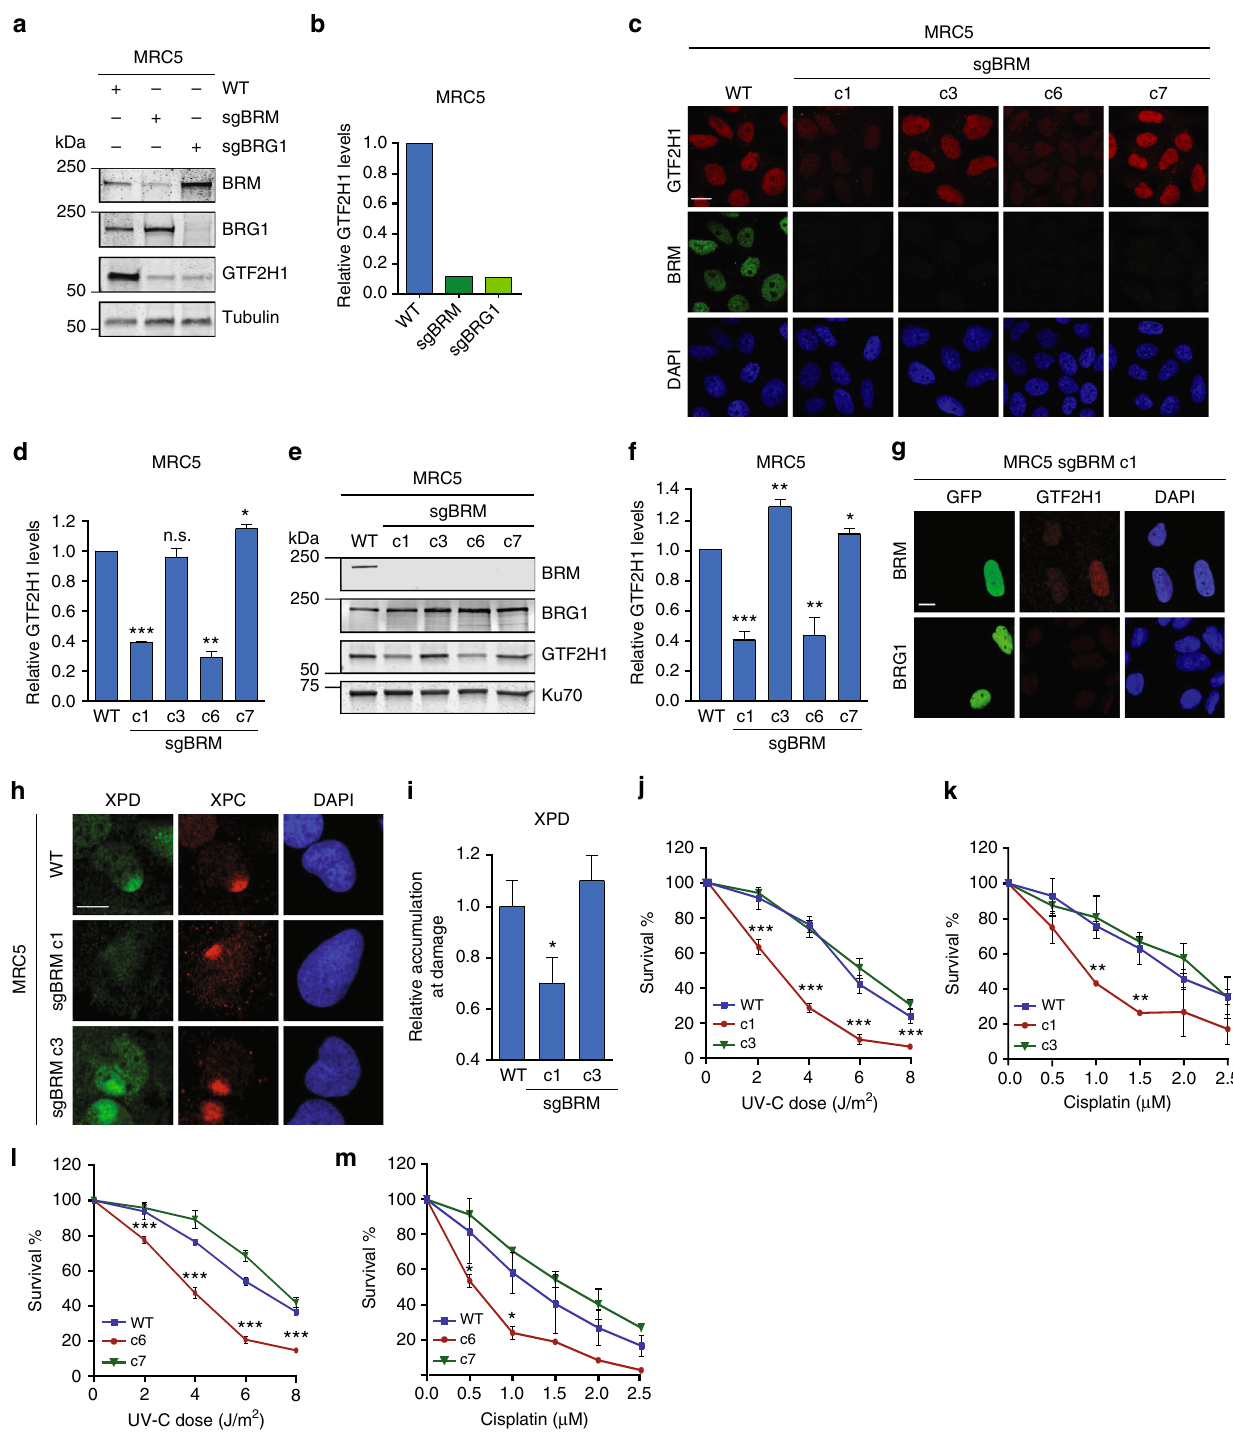
proposed, in facilitating XPG and PCNA — but not DDB2 and XPC — recruitment to sites of damaged DNA 24 . Our data, indeed, shows that both BRG1 and BRM are essential for ef fi cient recruitment of late NER factors (TFIIH and downstream NER proteins) rather than for binding of the early DNA damage sensing factors (XPC, DDB2, and CSB) to DNA lesions. Impaired recruitment of the late NER factors in the absence of SWI/SNF is, however, not caused by reduced chromatin accessibility, but an indirect result of limiting amounts of functional TFIIH.